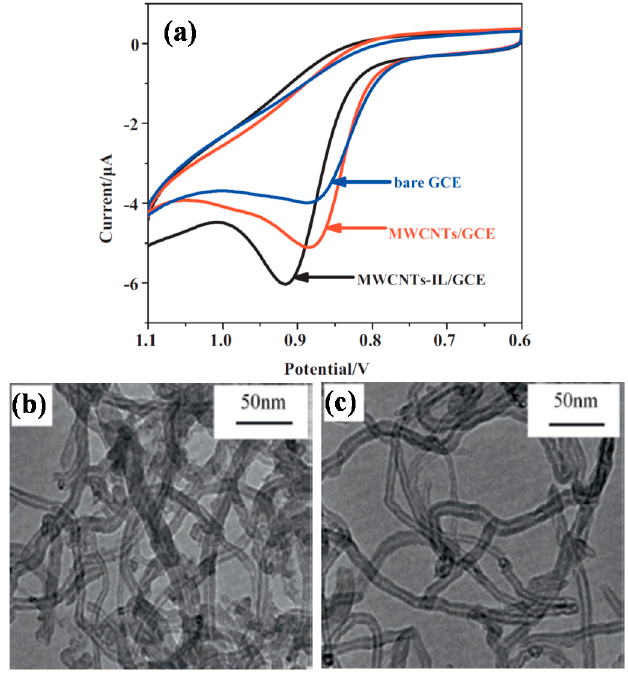
Figure 4. ( a ) CVs for 5.0 × 10 − 5 mol·L − 1 PMT on different electrodes in PBS (pH 6.0). TEM images of ( b ) MWCNTs and ( c ) MWCNTs-IL. (Reproduced with permission of Elsevier from [93]).